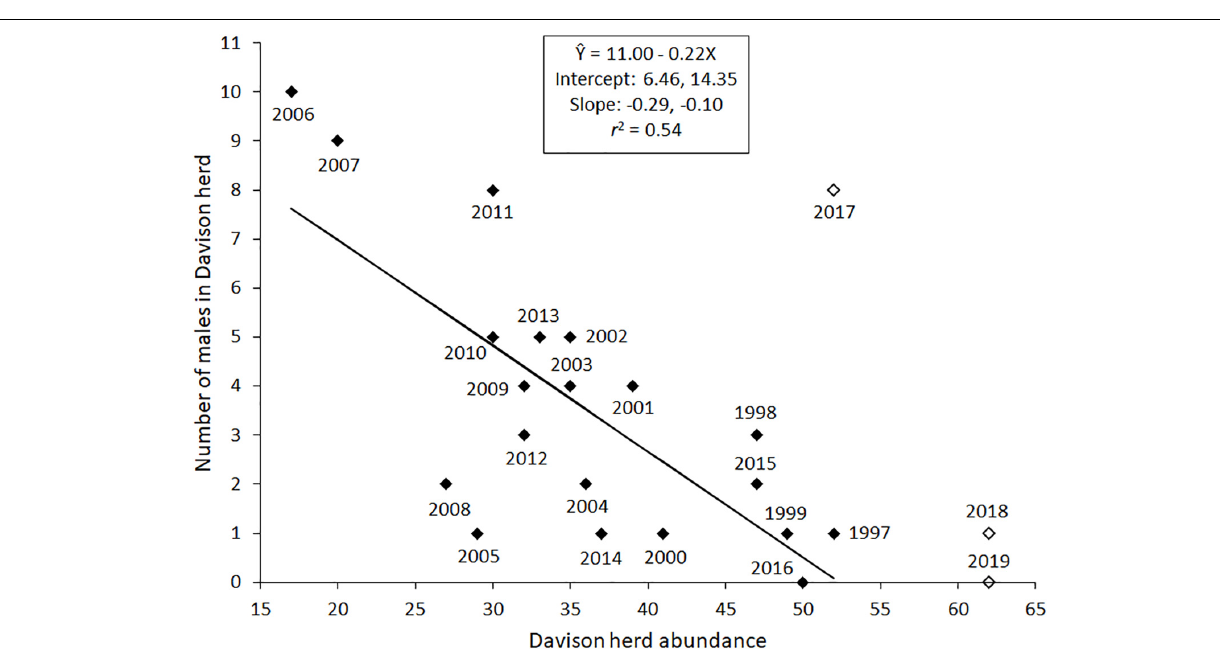
FIGURE 3 | Scatterplot of data and regression estimating high count of males in the Davison herd from Davison herd abundance for 1997–2016 (solid diamonds). The years 2017–2019 have open diamonds. Data in those years were not included in analysis because the herd expanded use into a new forage habitat and the result is likely to be an increase in K carrying